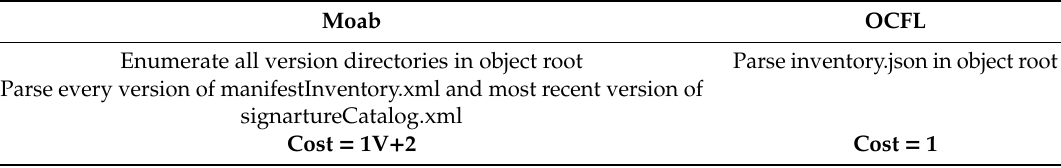
Table 1. Cost in filesystem calls to create index of all files in all versions of an object. Moab